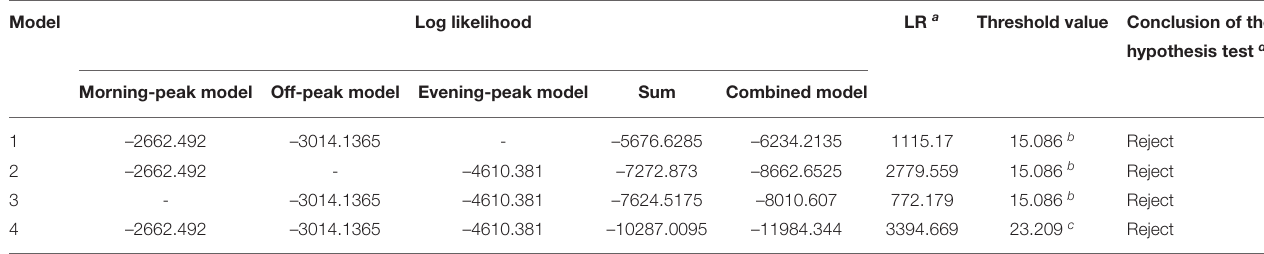
TABLE 4 | The results of the pooling test.